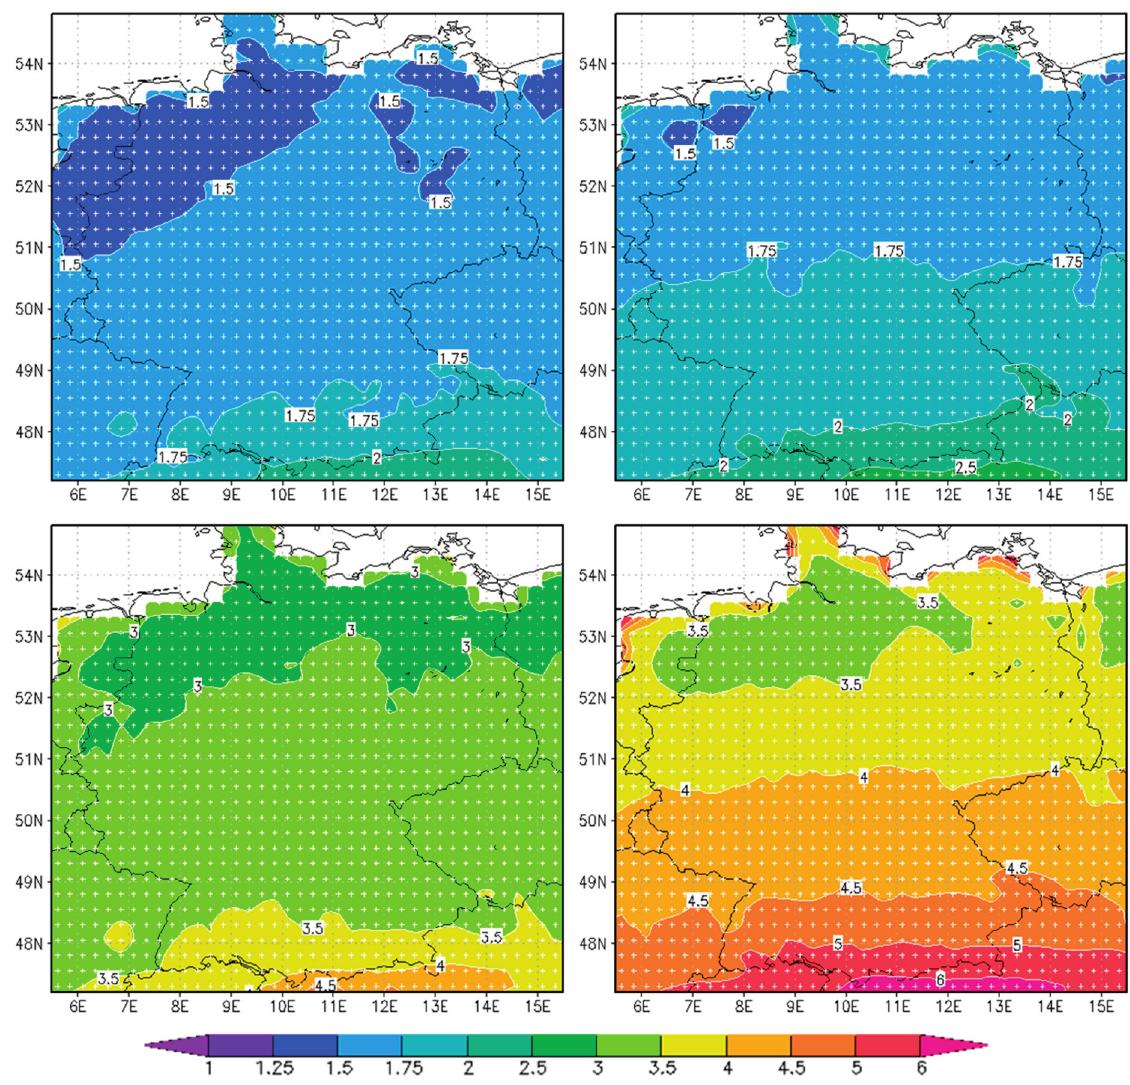
Figure 1. Projected ensemble mean of the annual number of heat waves ( left ) and heat wave days ( right ) for 2021–2050 ( top ) and 2069–2098 ( bottom ), expressed as ratio between scenario period and control period 1971–2000. Grid points with significant changes ( α < 0.05) between present and future climate are marked by white